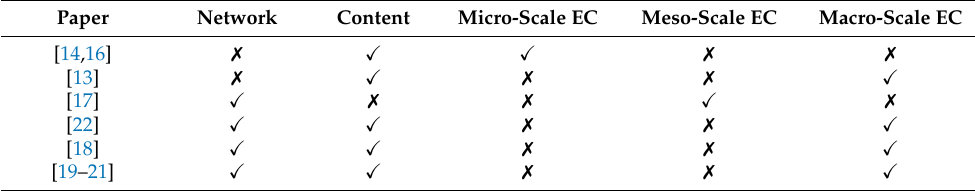
Table 1. Summary of related works for echo chamber detection on online social networks.